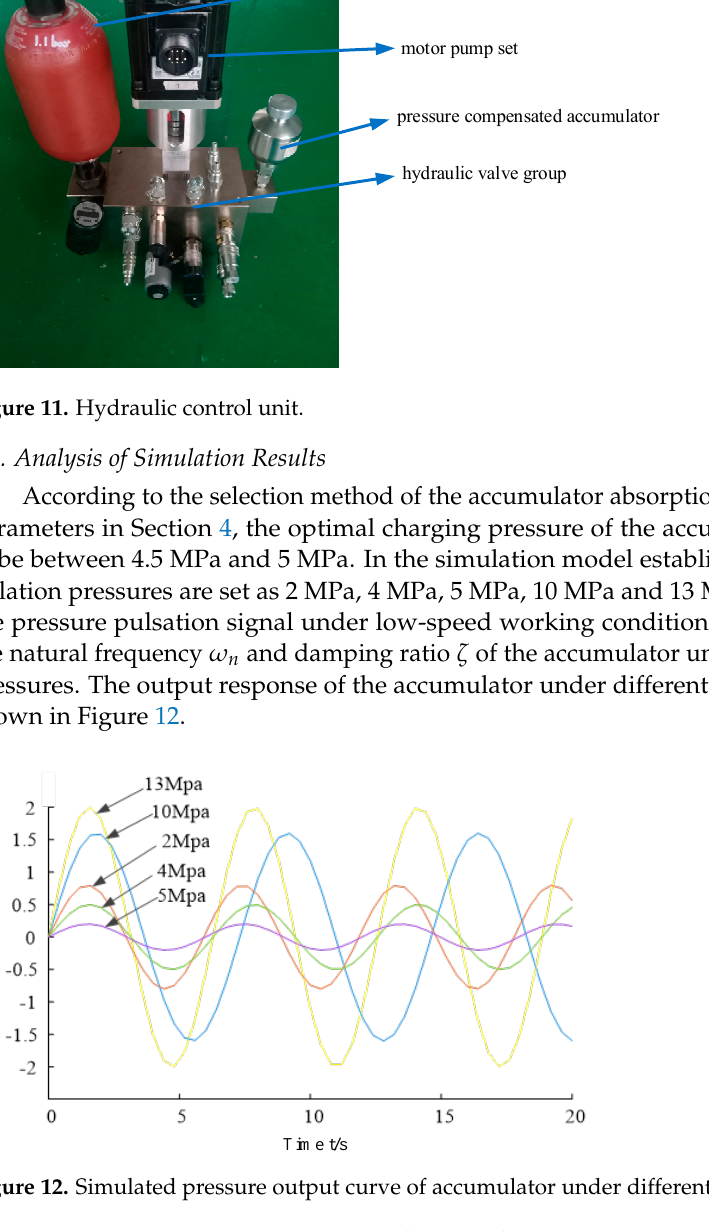
Figure 10. EHA electrical control system.